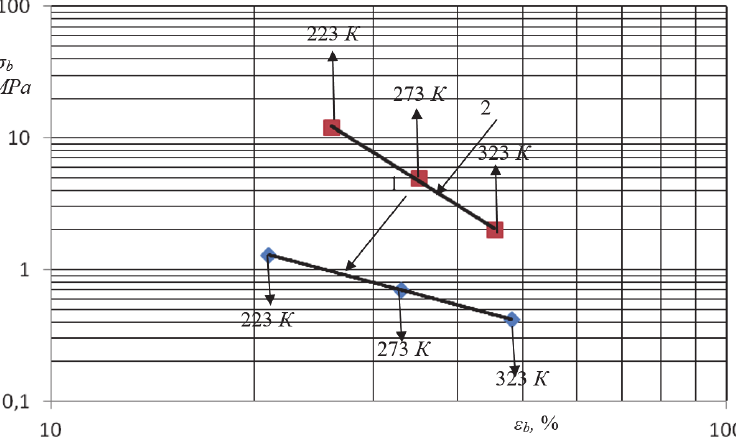
Figure 2: Envelopes of rupture points for polymer composite materials according to T. L. Smith: 1 – based on low-molecular rubbers BR-KTR + PDI- 3B; 2 – based on high-molecular rubbers IR + BR-